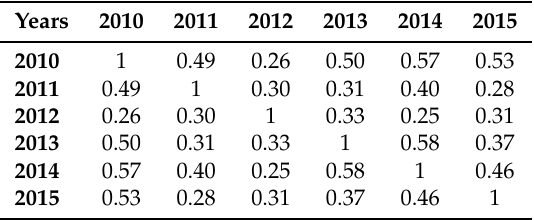
Table 2. Correlation matrix of the Spanish electricity prices of 2010–2015.